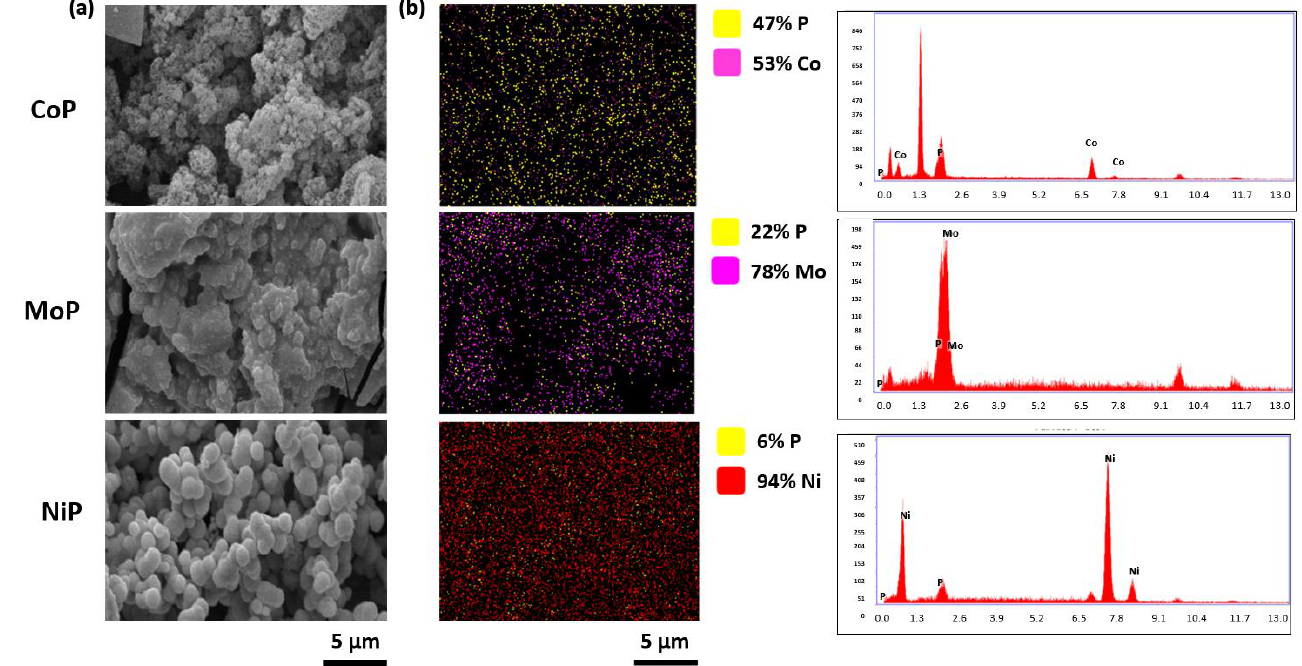
Figure 2. ( a ) SEM micrographs; ( b ) chemical analysis maps (left-hand side) and EDS spectrum of CoP, MoP, and NiP. Table 1. Summary of the chemical composition determined by the EDS analysis (in weight ( wt. (%)) and atomic percentage ( at. (%)), respectively) for the different phosphides investigated here. Phosphide Specimens CoP MoP NiP